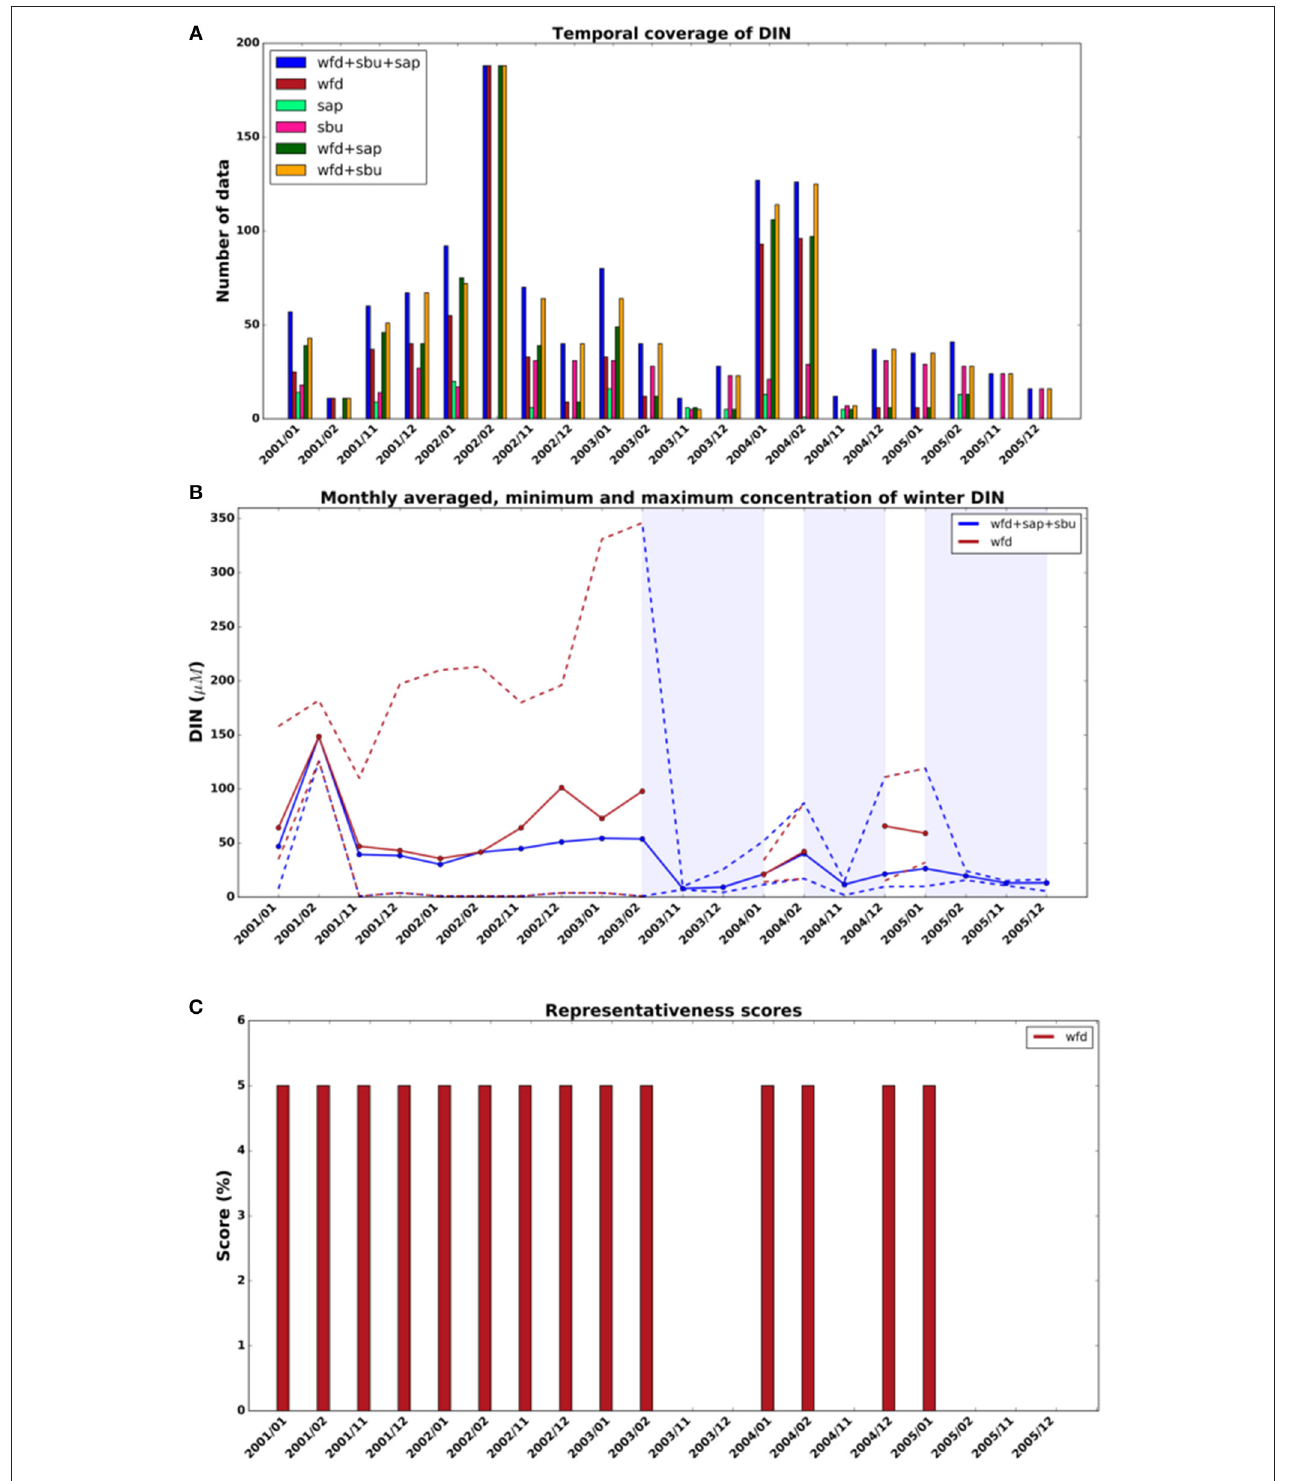
FIGURE 7 | (A) Temporal coverage: number of data per time interval of the DIN reference dataset and all the aggregation scenarios. (B) Monthly averaged time series of winter DIN concentration (solid line), and minimum and maximum monthly values (dashed lines) for the reference dataset and aggregation scenario wfd . (C) Representativeness score of each temporal interval following Brockmann and Topcu (2014). Since the number of intervals is 20, the maximum score per interval is 5% (100/20). The scores for the reference ( wfd + sap + sbu ) are not included because all the intervals get the maximum score.